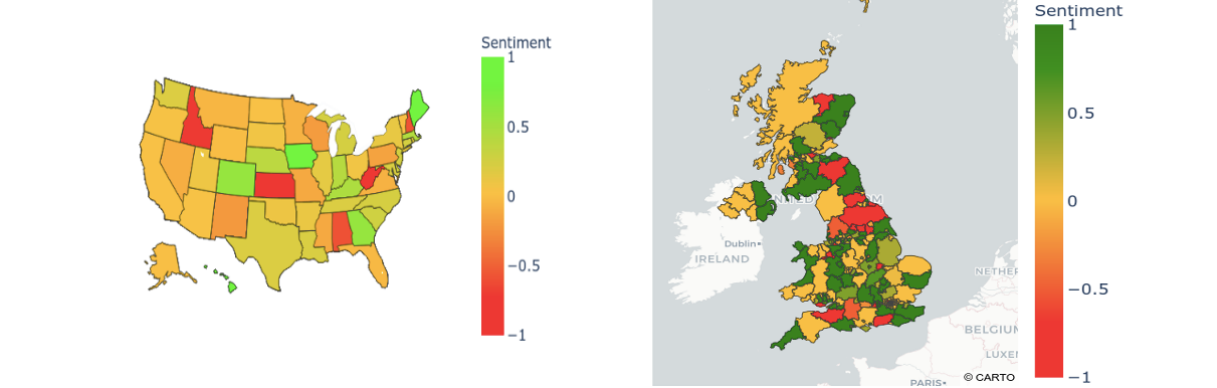
Figure 4. Geospatial mapping of averaged social media public sentiments in the United States (left) and the United Kingdom (right) toward COVID-19 vaccines (1 or green: positive sentiments, 0: neutral sentiments, and -1 or red: negative sentiments).